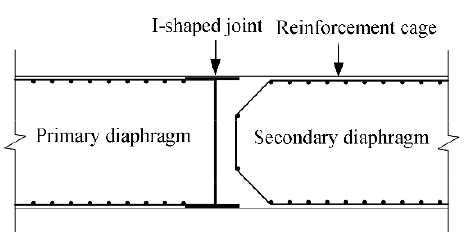
Figure 4. Geometry of the I-shaped sheets used as joints between adjacent diaphragm wall (D-wall) panels (top view).